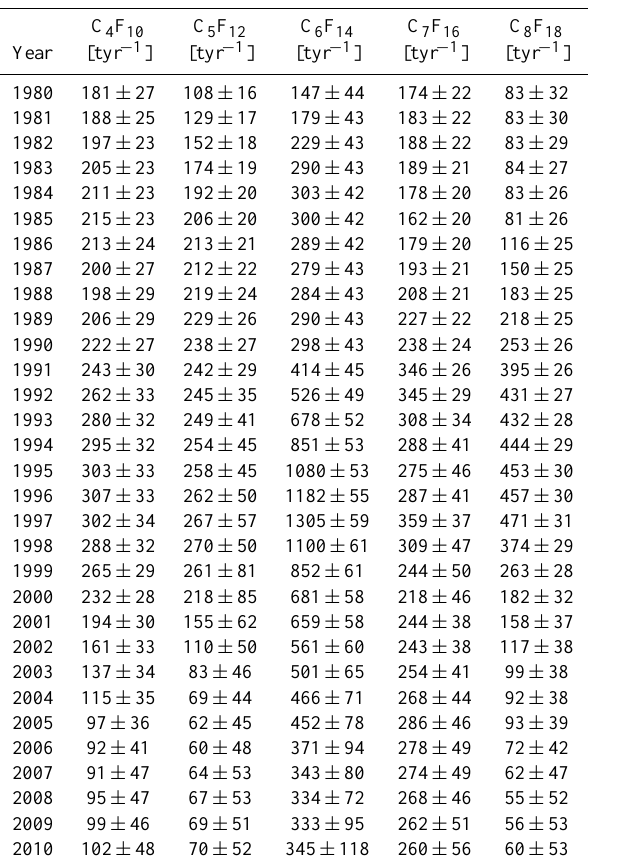
Table 3. Annual mean global emission rates and uncertainties for